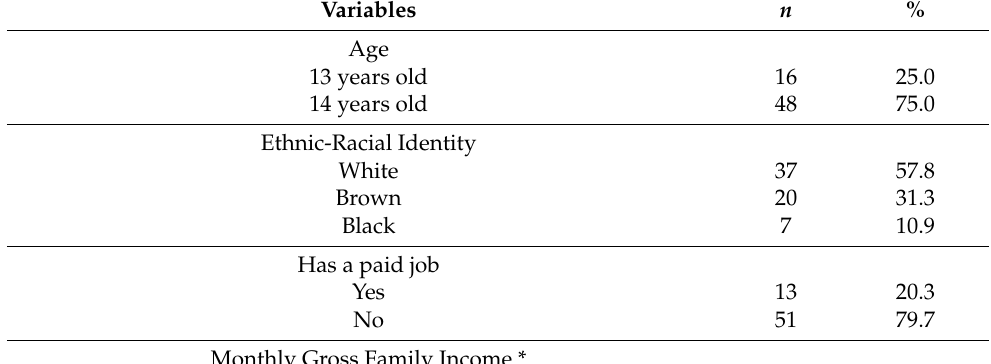
Table 1. Sociodemographic and professional characteristics of selectable athletes for the Brazilian handball team—children